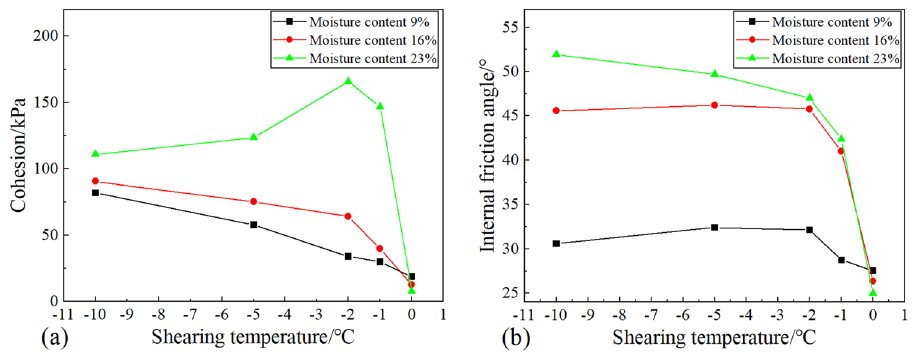
Figure 9. Effect of shear temperature on the shear index of soil-ice interface: ( a ) Cohesion; ( b ) Internal friction angle.